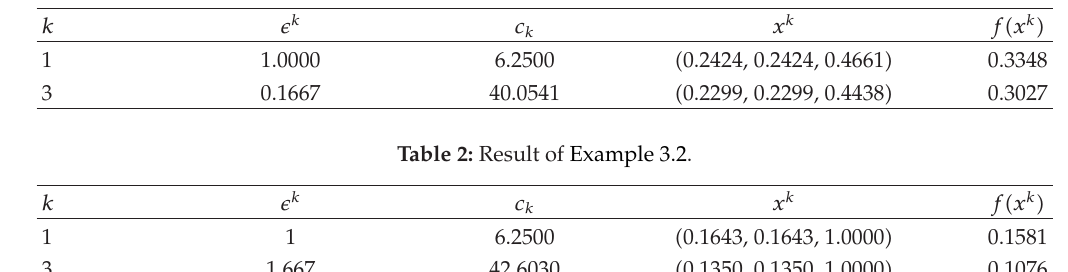
Table 1: Result of Example 3.1.